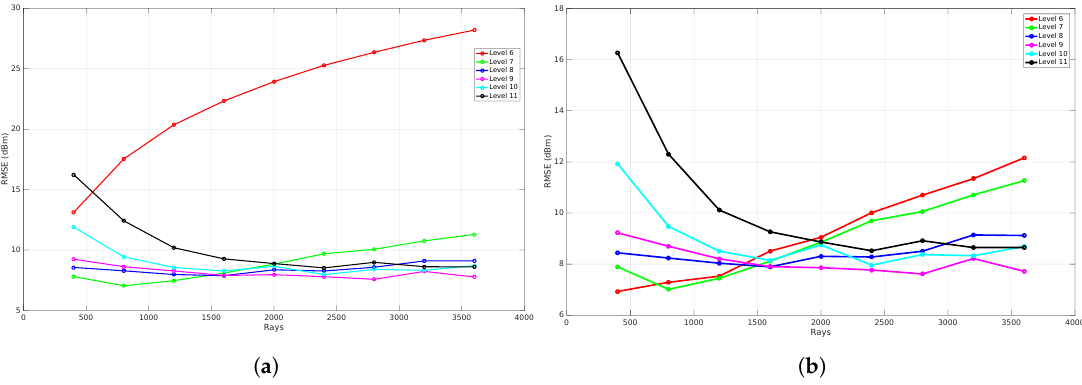
Figure 24. RMSE validation of the second office environment where eight neighbors are included. ( a ) no phase shifts are included; ( b ) phase shifts are included.